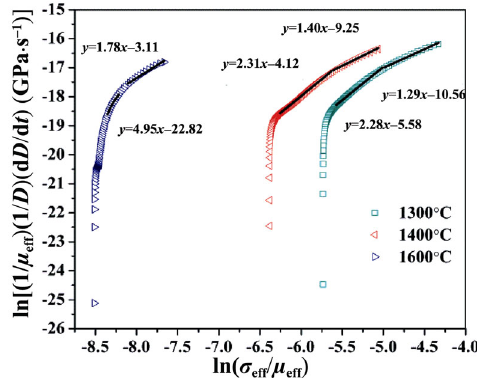
Fig. 7 Stress exponent n calculated with Eq. (4) for different soak temperatures and the specific values of n are the slopes of the fitting straight lines.